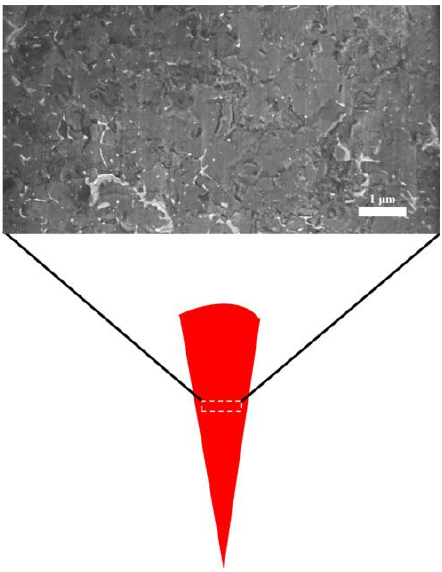
Figure 7. Overview TEM image of the focused ion beam (FIB) specimen derived from Coating 3.